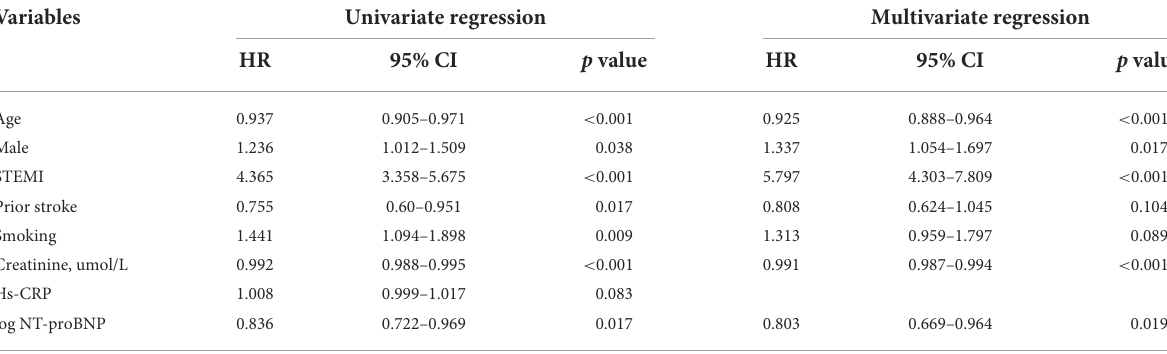
TABLE 3 Logistic regression analyses for factors related to PCI decision-making in very elderly ACS patients.